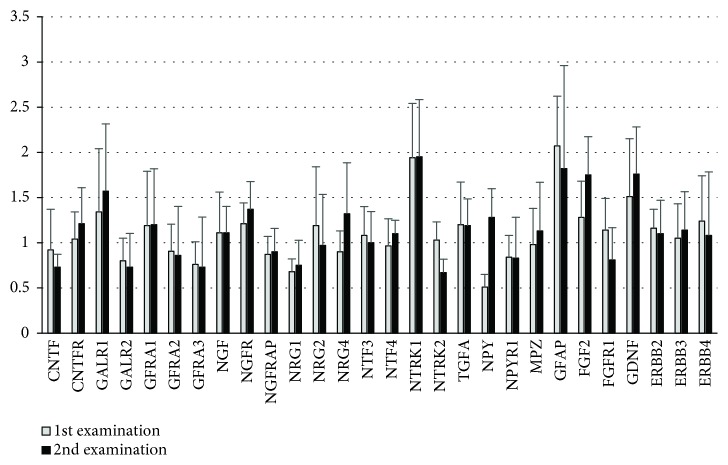
Comparison of the neurotropic factor expression profile in skin biopsies in Tx1 1st and 2nd examinations. The 1st examination was performed early after transplantation and the 2nd examination after the median 28-month period of normoglycemia. Data shown as median and 3rd quartile values. Wilcoxon signed-rank test: p > 0.05 for all parameters. The y-axis shows a relative expression of selected neurotrophins calculated by ΔΔCt method using a normalized expression of each target gene in HC group as a calibrator.